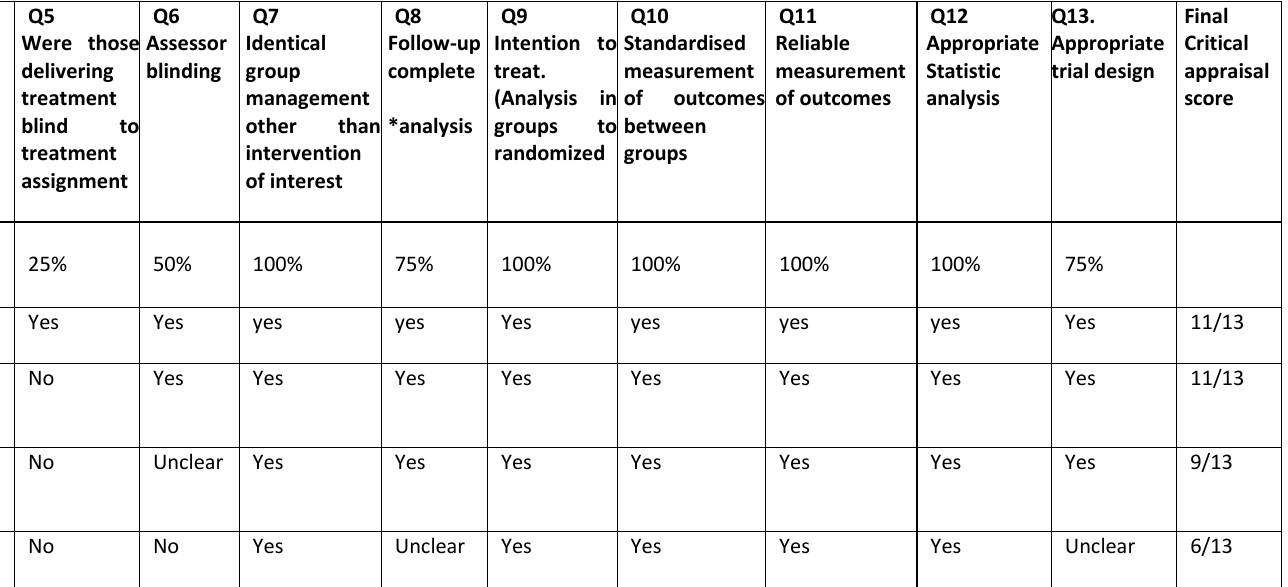
TABLE 3-A1: Critical appraisal